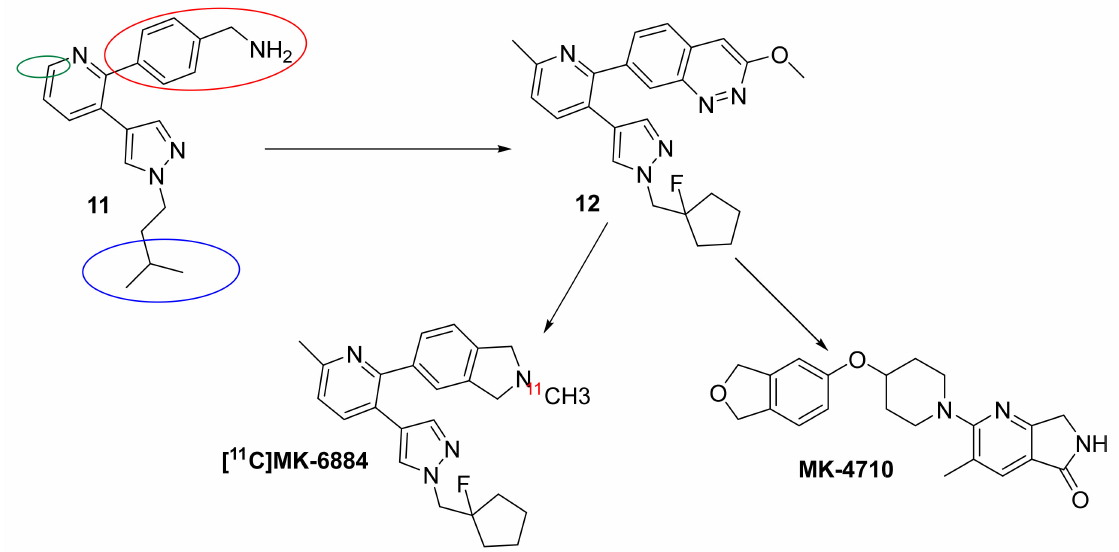
Figure 7. Optimized M 4 selective PAMs recently disclosed by